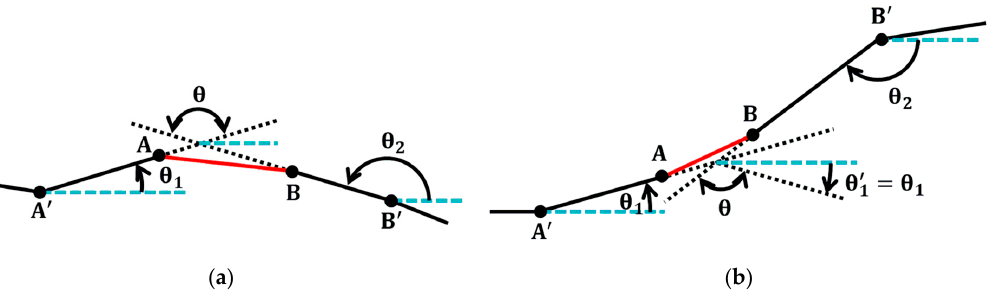
Figure 10. Angle rule between vectors: ( a ) the two vectors are on the same side of the horizontal line; ( b ) the two vectors are on opposite sides of the horizontal line.